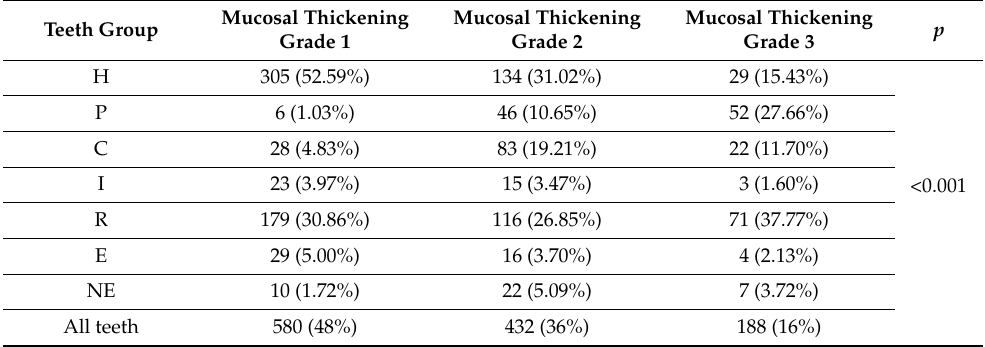
Table 5. Comparative analysis of the average mucosal thickening, classified in a three-grade scale and odontogenic condition. Teeth